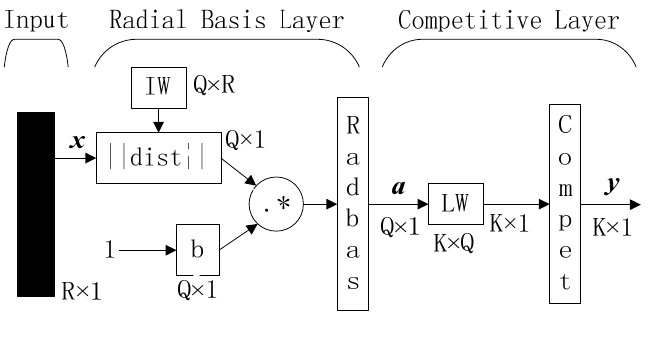
Figure 1. Outline of PNN (R, Q, and K represent number of elements in input vector, input/target pairs, and classes of input data, respectively. IW and LW represent input weight and layer weight, respectively).